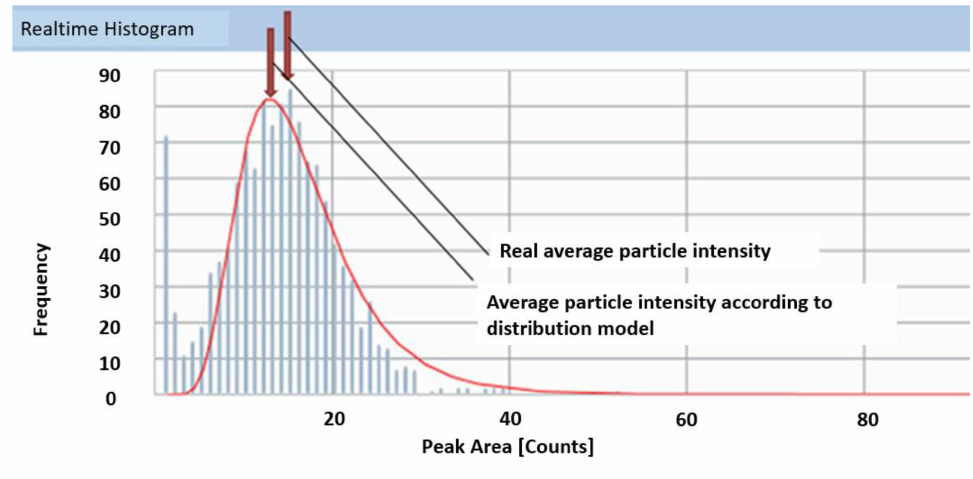
Figure 6. Nanoparticle intensity-frequency distribution histogram with fitting curve for prod- uct